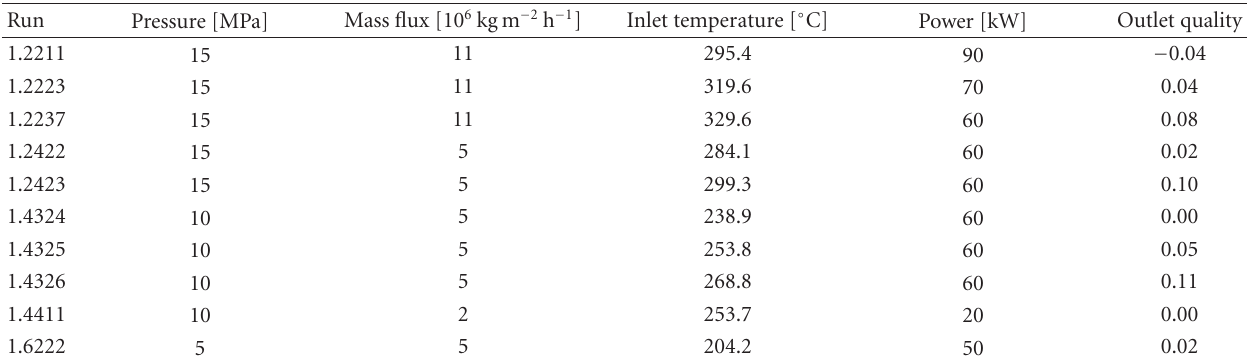
Figure 1: Test section for the subchannel void measurement [10]. Table 1: Selected